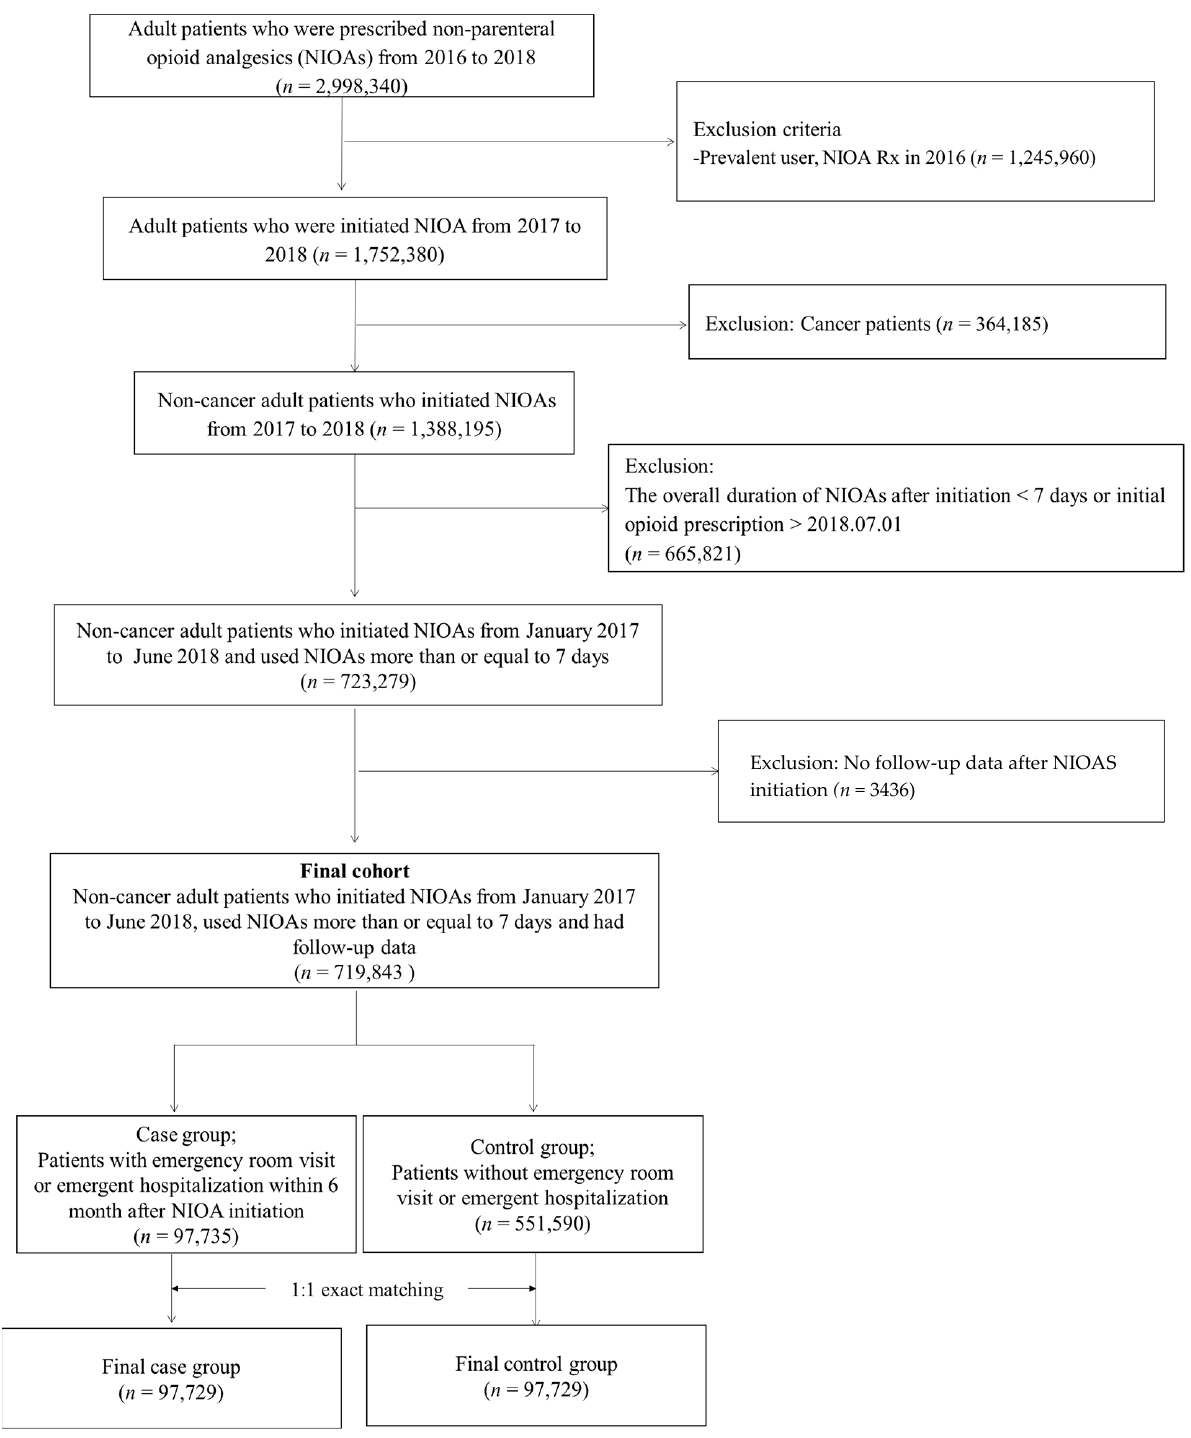
Figure 1. Patient selection flow. NIOA; non-injectable opioid analgesics. The patients had a mean age of 60.25 ± 17.28 years, 43.21% were male, and 8.37% had Medicaid or National Meritorious Service (NMS) insurance. The most common comor- bidities were hyperlipidemia (52.33%) and hypertension (48.25%), and the mean Charlson comorbidity index was 2.50 ± 2.26. Before NIOA initiation, almost one quarter of pa- tients had visited the ED, and the mean number of days of healthcare utilization was 43.03 ± 49.64. Common co-medications used one month before the index date were